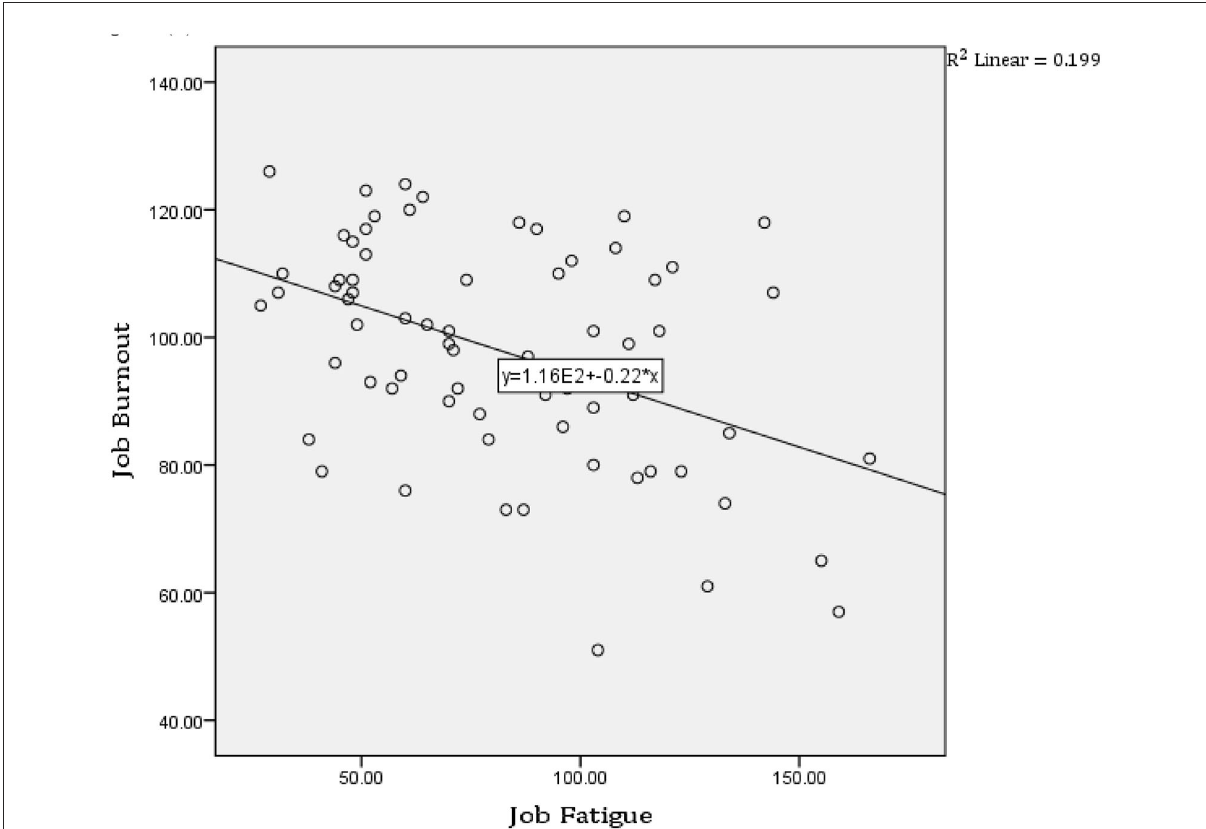
FIGURE1 Evaluation of the relationship between the dimensions of the burnout inventory and the dimensions of the occupational fatigue